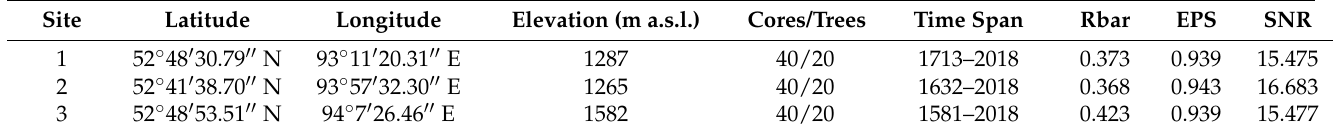
Figure 1. Locations of the sampling sites in the Sayan Mountains, Southern Siberia, Russia, and the nearest meteorological station, Minusinsk Station. Table 1. Site information and results of the common period analysis (1762 – 2018).